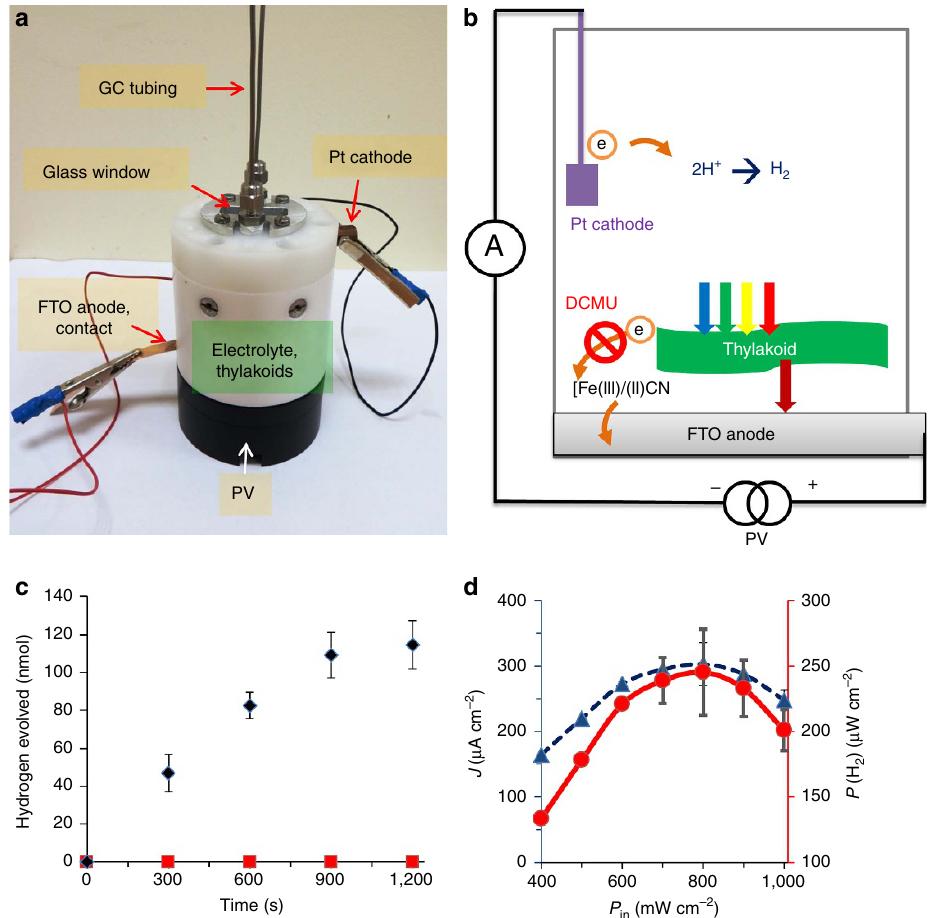
Figure 7 | PV–BPEC tandem cell. ( a ) Photograph of the tandem cell. ( b ) Illustration of the electron transfer pathway in the tandem cell. ( c ) Hydrogen evolution at the cathode in the presence (red squares) or absence (black diamonds) of the herbicide DCMU. ( d ) The influence of the incident light intensity ( P in ) on the photocurrent (blue curve) and power accumulated in hydrogen bonds (red curve) produced by the tandem cell. The error bars in c , d represent the s.d. in four independent